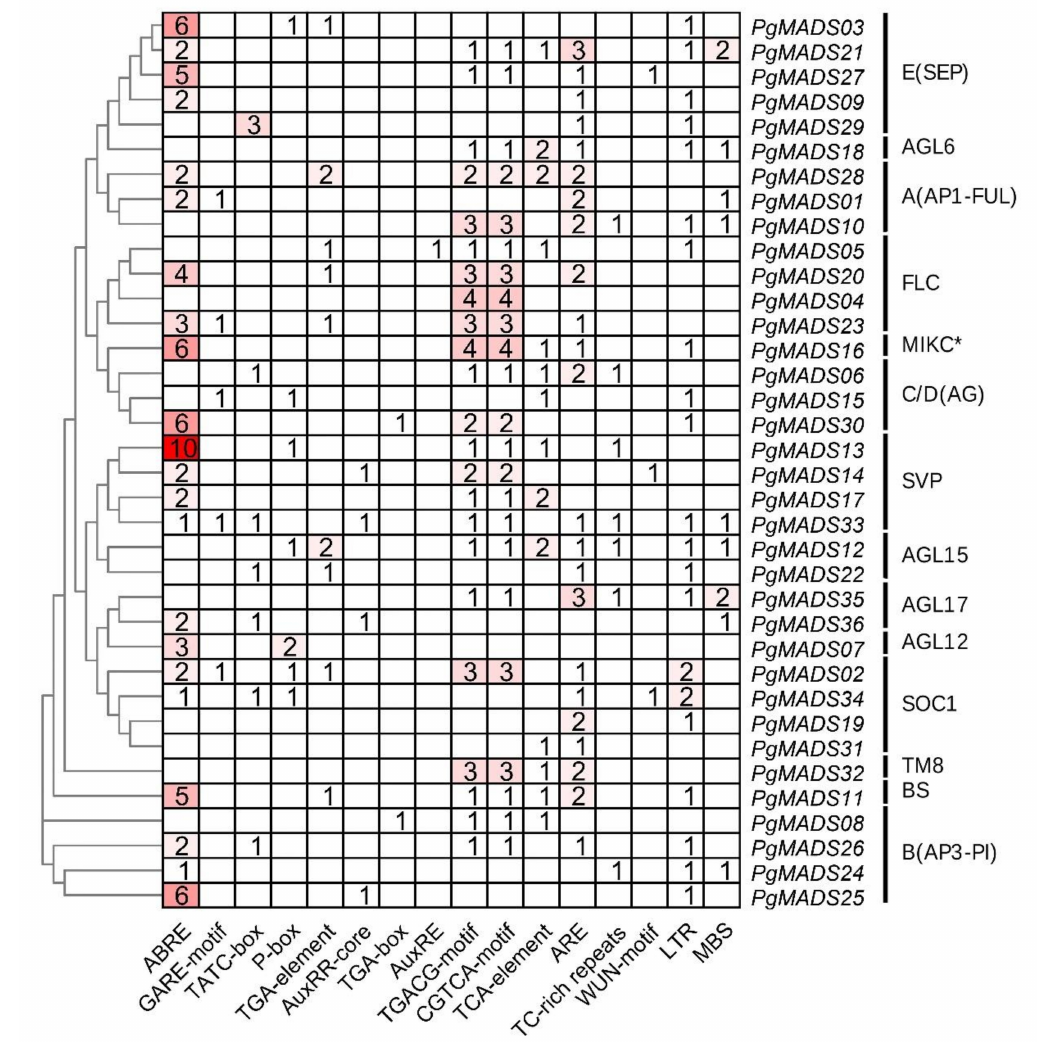
Figure 3. Analysis of Cis -acting elements of MIKC-type MADS-box gene family in pomegranate. ABRE is abscisic acid response element; P-box, TATC-box and GARE-motif are gibberellin response element; AuxRE and AuxRR are regulatory auxin responsiveness element; TGA-element and TGA-box are auxin response element; ARE is antioxidant response element; CGTCA-motif methyl jasmonate response element; LTRiscoldstressresponseelement; TCA-motifissalicylicacidresponseelement;